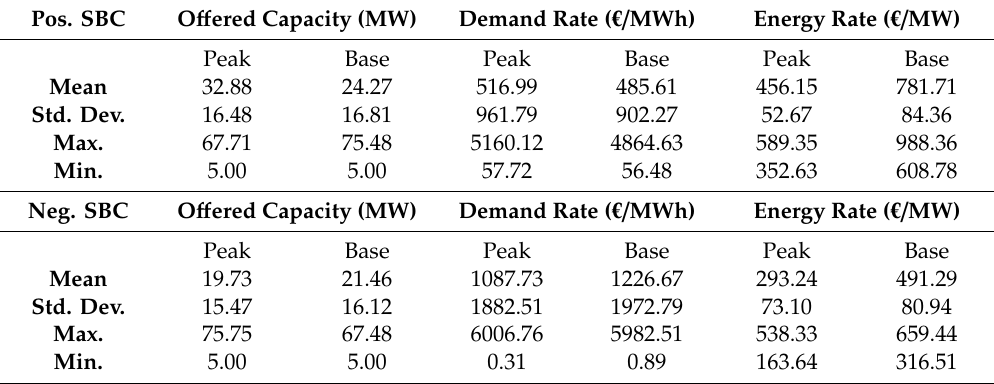
Table 10. Prices for positive and negative secondary reserve capacity in Germany,